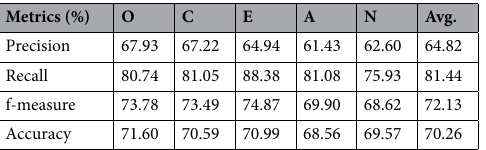
Table 3. Evaluation results for APP using KGrAt-Net when classification is performed using knowledge graph attention network.